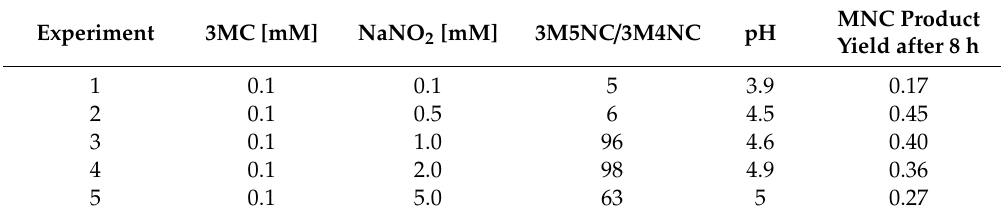
Table 1. Ratios and yields of quantified 3-methyl-5-nitrocatchol (3M5NC) and 3-methyl-4-nitrocatechol (3M4NC) at di ff erent NaNO 2 concentrations under sunlight conditions after 8 h of reaction.